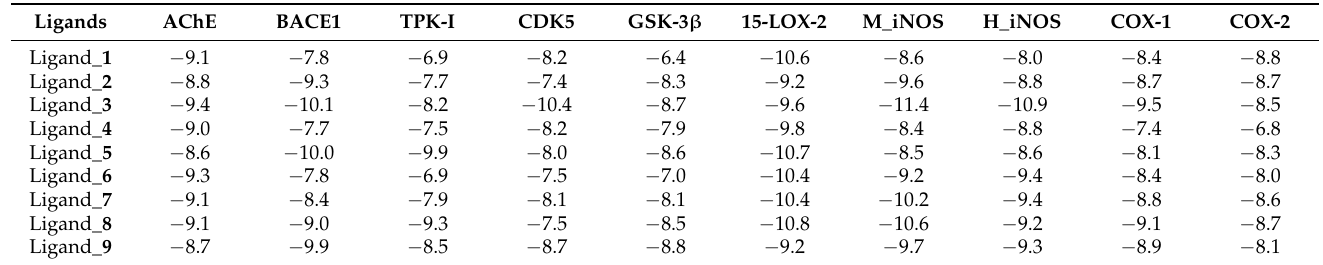
Table 2. Therapeutic efficacy of nine natural products against ten target enzymes based on protein– ligand binding or the molecular docking score